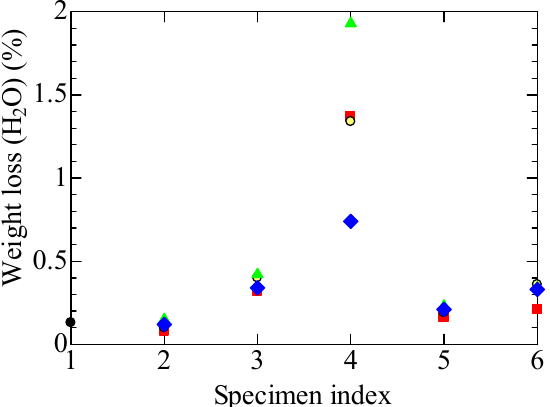
Figure 7. Weight losses measured at each stage in various tubular specimens due to the desorption of H 2 O in the range of 50 to 150 °C. Refer to Tables 1 and 2 and Figure 4 for the meanings of the numerals on the abscissa and sample symbols. Several data may overlap each other.